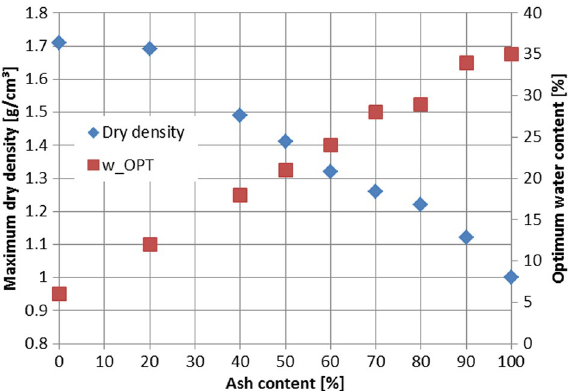
Fig. 1. Maximum dry density and optimum water content of the different sand ash mixtures